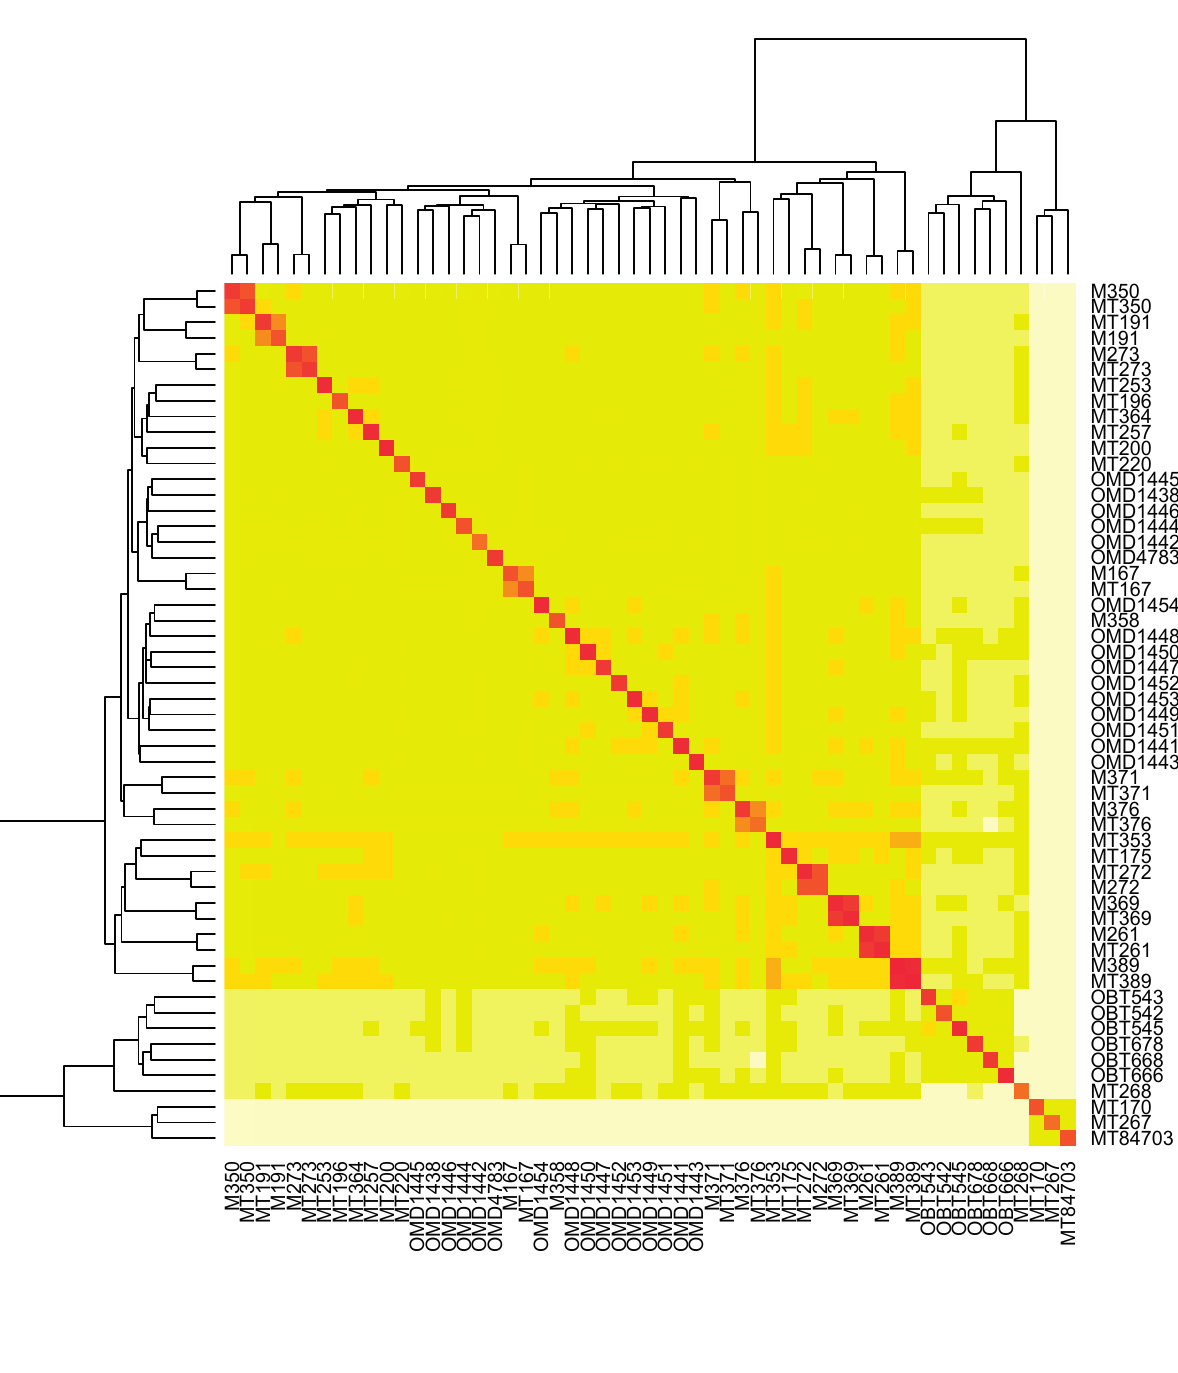
Figure 8. The heatmap depicts the entries in a square matrix in which the ( i, j ) entry is the number of CrERV assignments in common, as predicted by the mixture model, for animals i and j . Entries along the diagonal are the number of predicted CrERVs total for each animal. Darker (redder) colors indicate larger values, and the rows and columns are sorted automatically by the plotting function so as to keep similar columns close together. A total of 55 animals, including the replicates, are